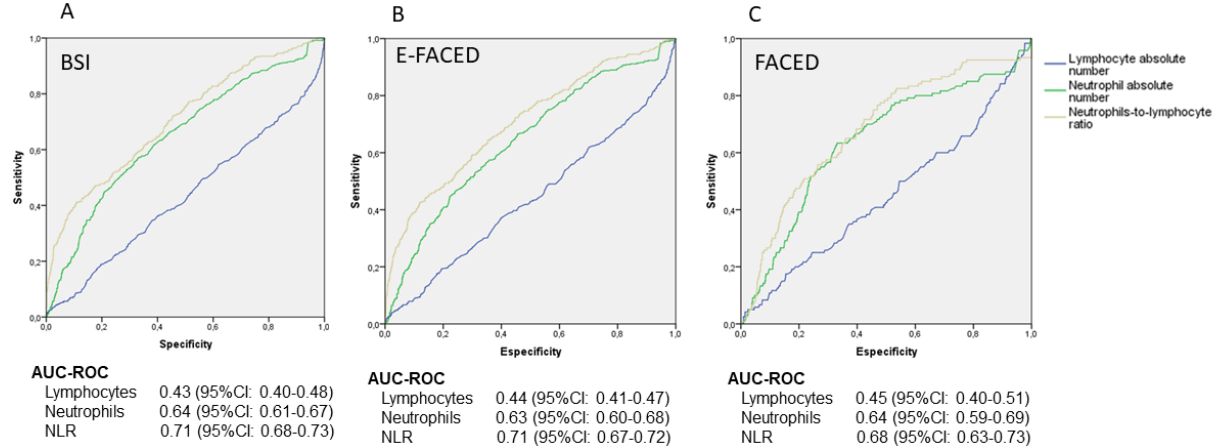
Figure 2. Prognostic capacity of the neutrophil-to-lymphocyte ratio for severe bronchiectasis, ac- cording to the Bronchiectasis Severity Index ( A ), E-FACED ( B ) and FACED ( C ). BSI: Bronchiectasis Severity Index, NLR: neutrophil-to-lymphocyte ratio; AUC-ROC: area under curve-ROC.